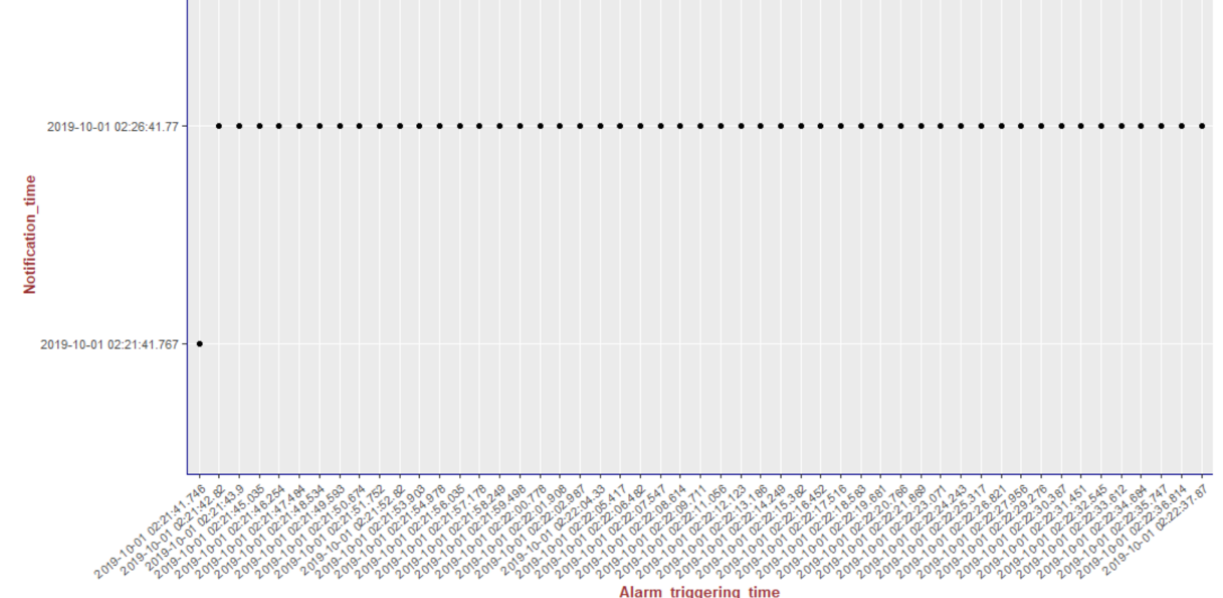
Figure 10. Illustration of the results of the alarm triggering and delivery processes related to the patient monitored in our experiment 5